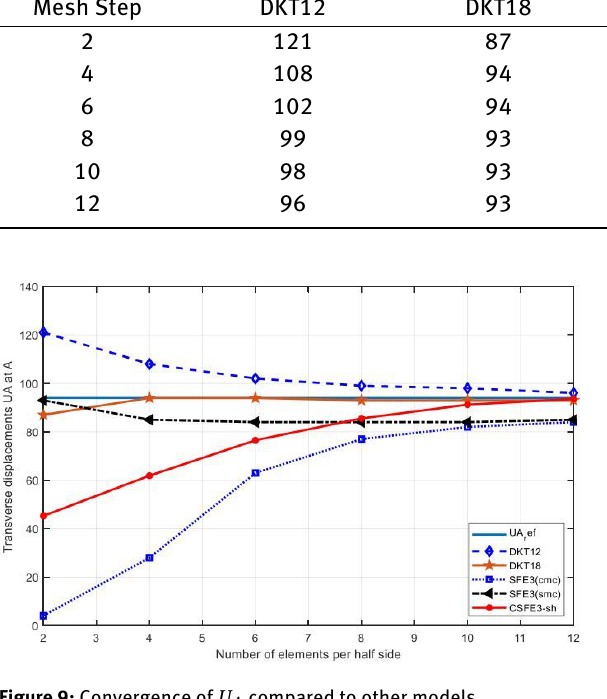
Figure 9: Convergence of U A compared to other models